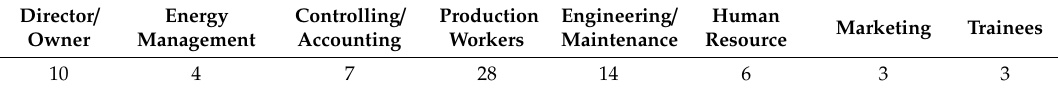
Table 2. Shares on the roles of the interviewed persons of the